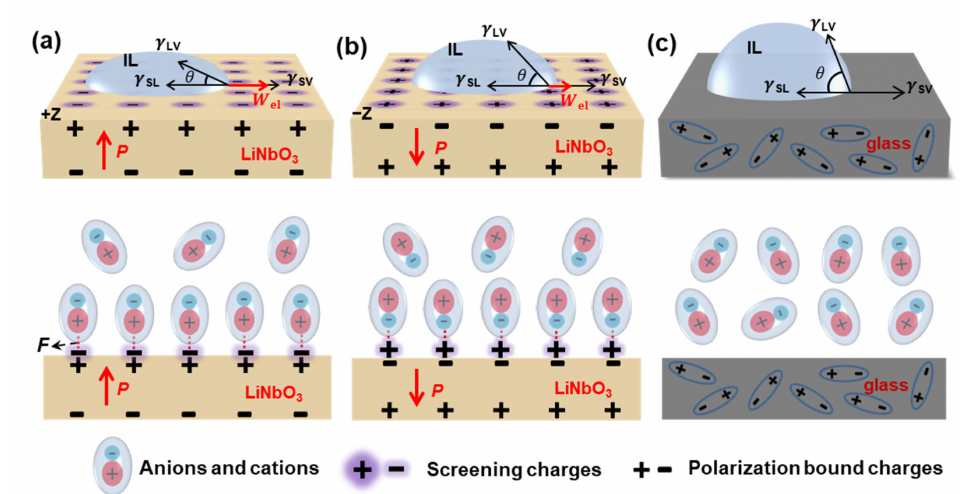
Figure 5. Wetting mechanisms of the IL on the LiNbO 3 and glass substrates after the heating pretreatment. ( a ) LiNbO 3 substrate with +Z surface, ( b ) LiNbO 3 substrate with − Z surface, ( c ) glass